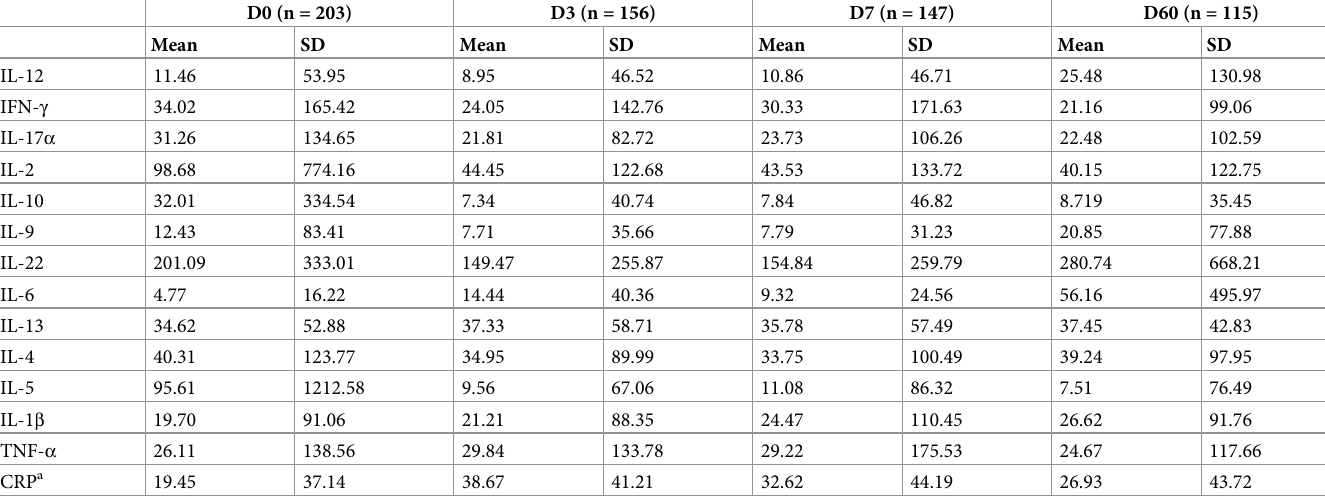
Table 2. Measured cytokine levels for patients before transarterial chemotherapy (D0) and at 3 days (D3), 7 days (D7), and 60 days (D60) post-transarterial chemotherapy a